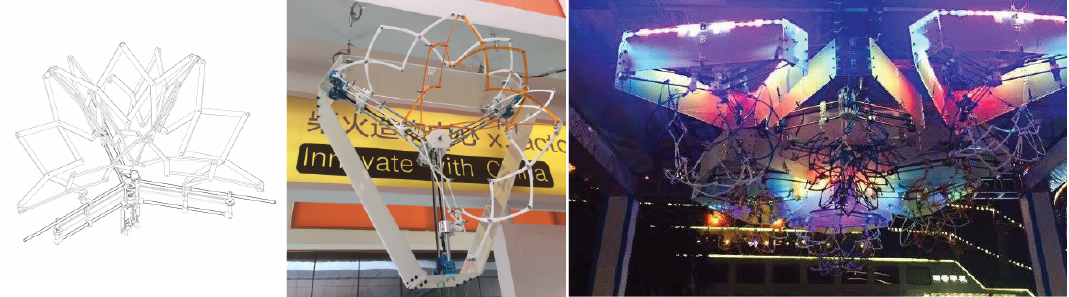
Figure 12. The outcomes of our research: ( left ) design research into the carrier component structures; ( middle ) detailed design, fabrication and assembly of a single adaptive component; and ( right ) public installation of an RCCE prototype at the Shenzhen MakerFaire